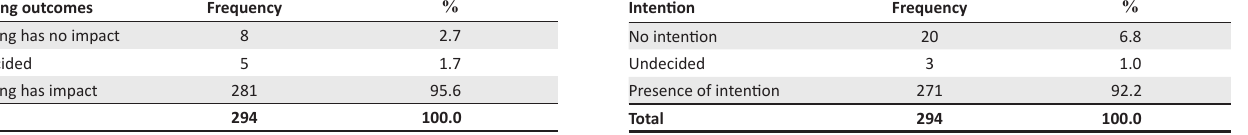
TABLE 6: Overall level of expected learning outcomes perception. Learning outcomes